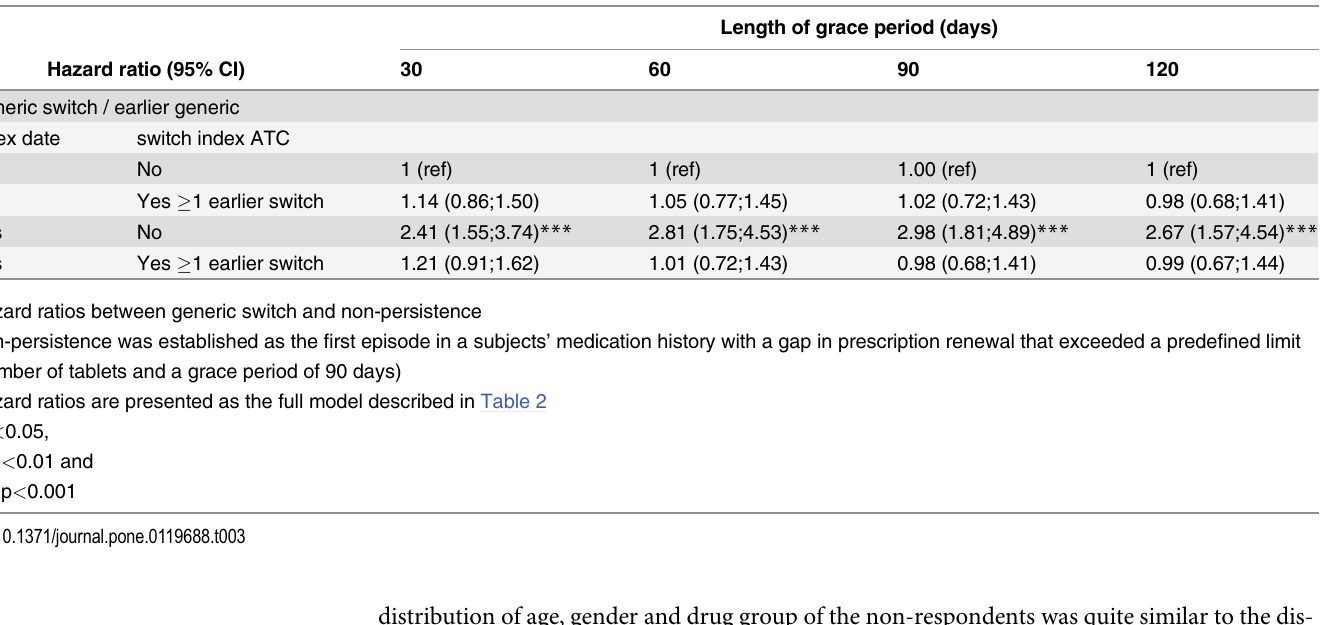
Table 3. In fl uence of length of grace period on estimated